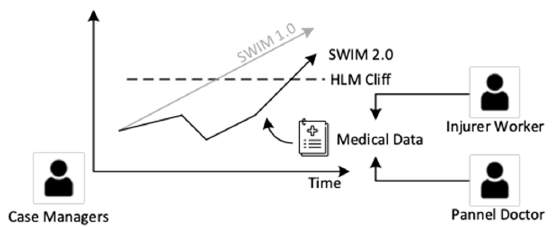
Figure 11. Comparison of SWIM 1.0 and 2.0 prediction model.